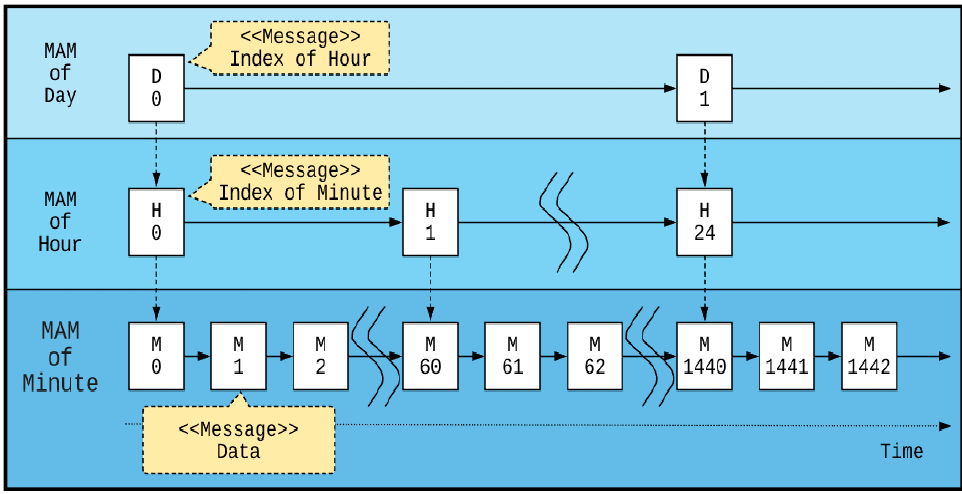
Figure 7. Tree-based masked authenticated message (TBMAM) indexing .